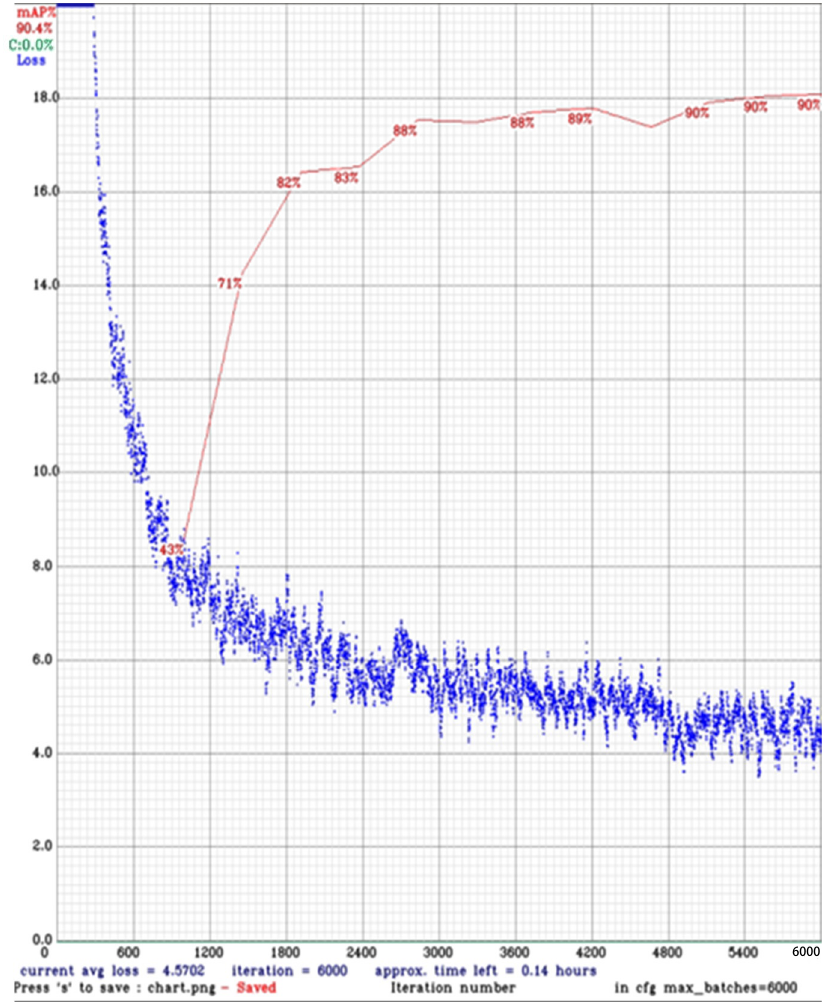
Figure 9. RTX 2080TI trained the best performing models: mAP vs. avg. loss: Model with IoU loss removed and IoU normalization change from 0.05 to 0.07 with default hyperparameters settings at an image resolution of 512 × 512 giving reduced mAP of 90.1 and better avg loss of 4.57.